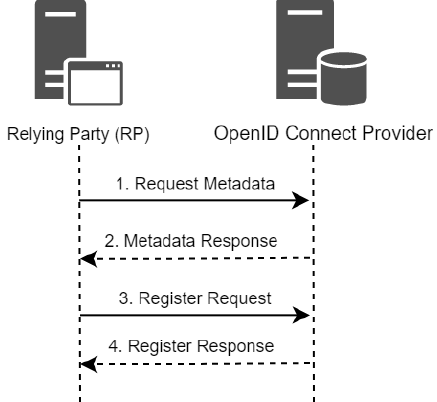
Figure 3. OIDC Dynamic Client Registration